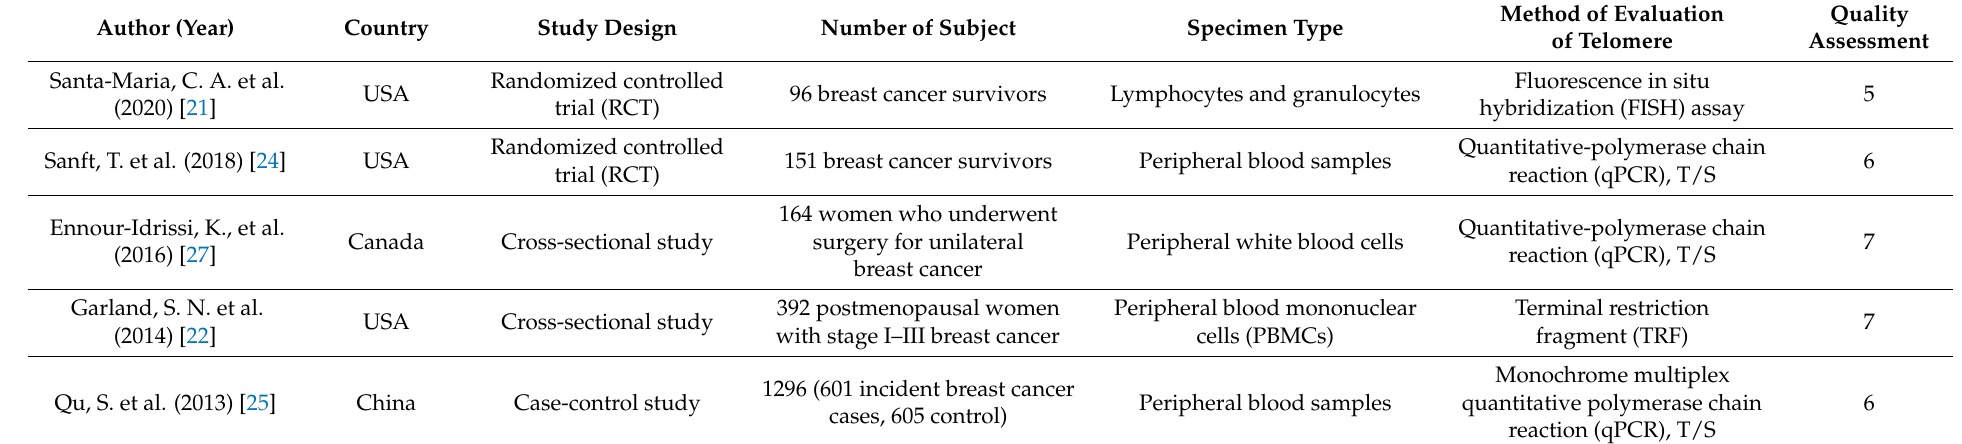
Table 1. Characteristics and quality assessment of included studies.